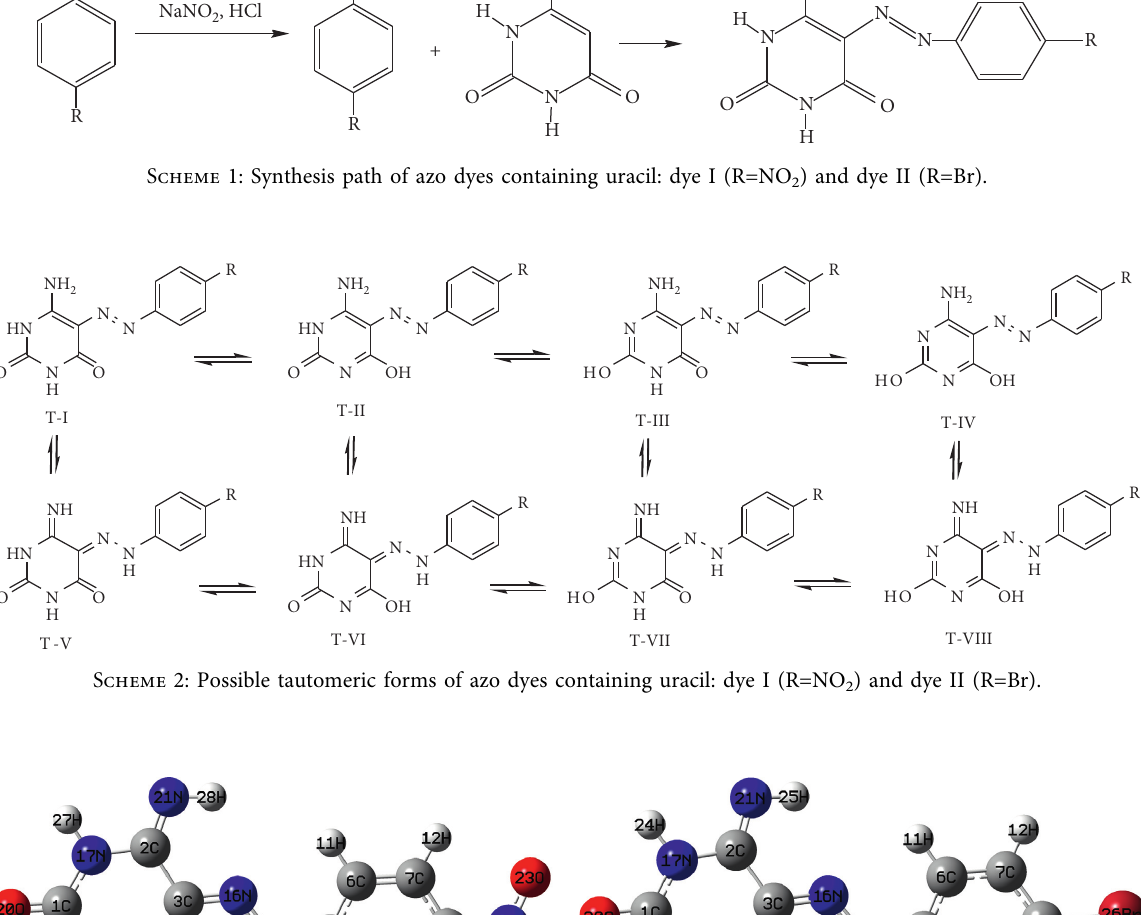
Figure 3. For this reason, possible tautomeric forms to T-IV